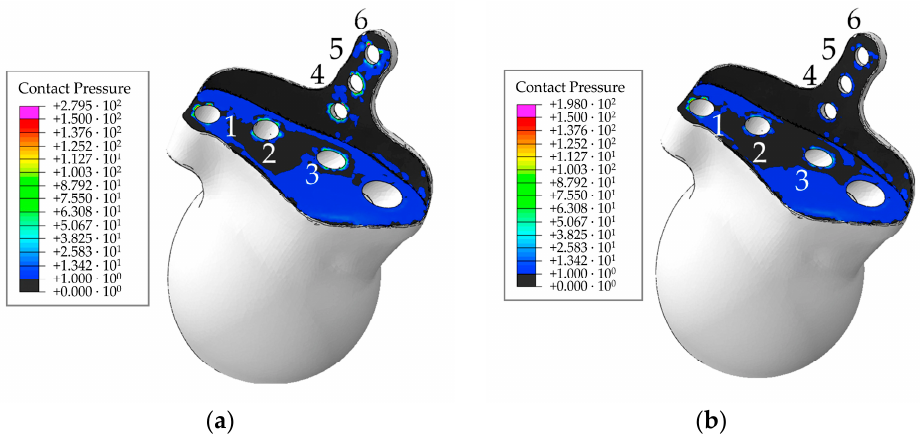
Figure 30. Contact pressure and the hole numbering convention for the walking cycle: ( a ) for a pretension force of 500 N; ( b ) for a pretension force of 50 N, MPa.